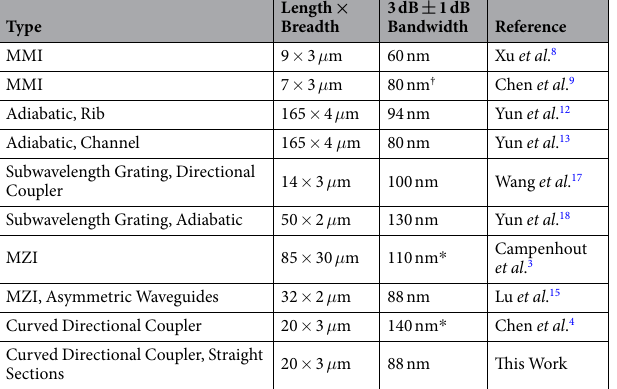
Table 1. Recent results of TE mode wavelength insensitive 2 × 2 port 3 dB power splitters on SOI platform. * Estimated from balanced MZI extinction. † Simulation result.